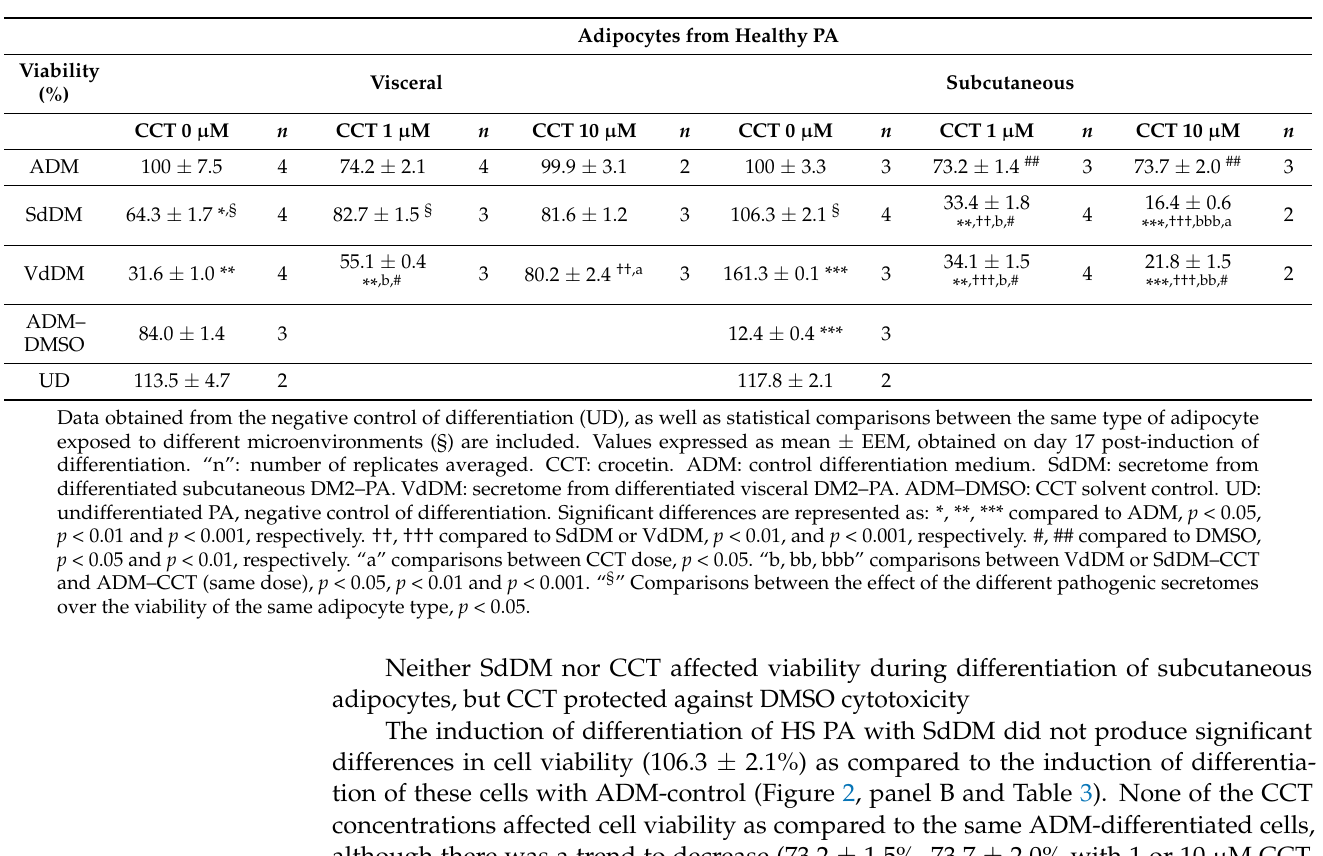
Table 3. Summary of viability